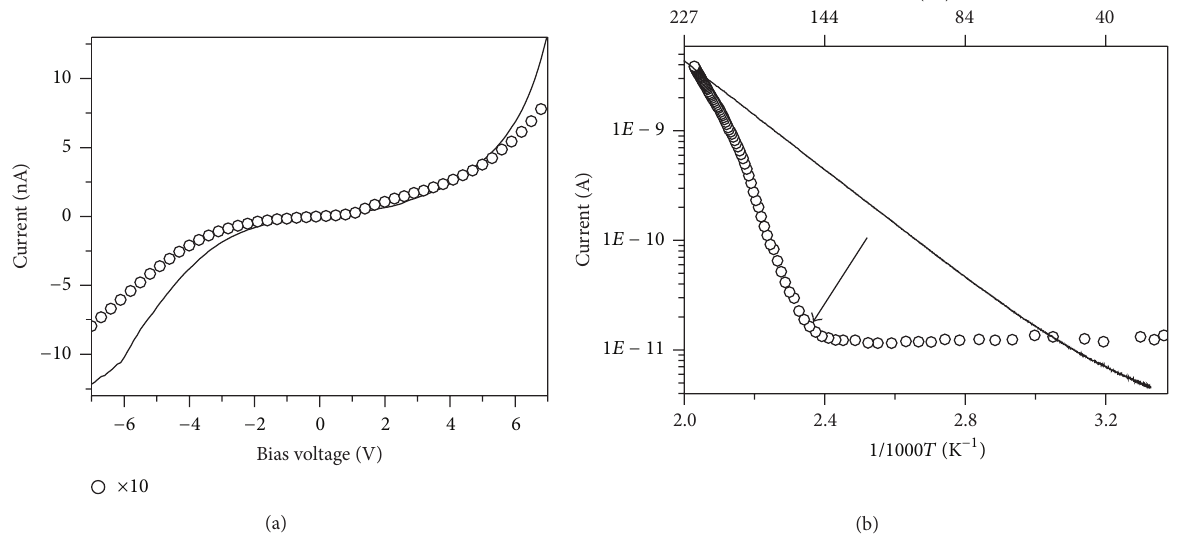
Figure 8: (a) 𝐼(𝑉) curves of an TiO 2−𝑥 nanosensor at room temperature in 50% relative humidity (continuous line) and dry (open circles multiplied by 10) atmospheres. (b) The Arrhenius plot of TiO 2−𝑥 nanosenor in warming up (open circles) and cooling down (continuous line).